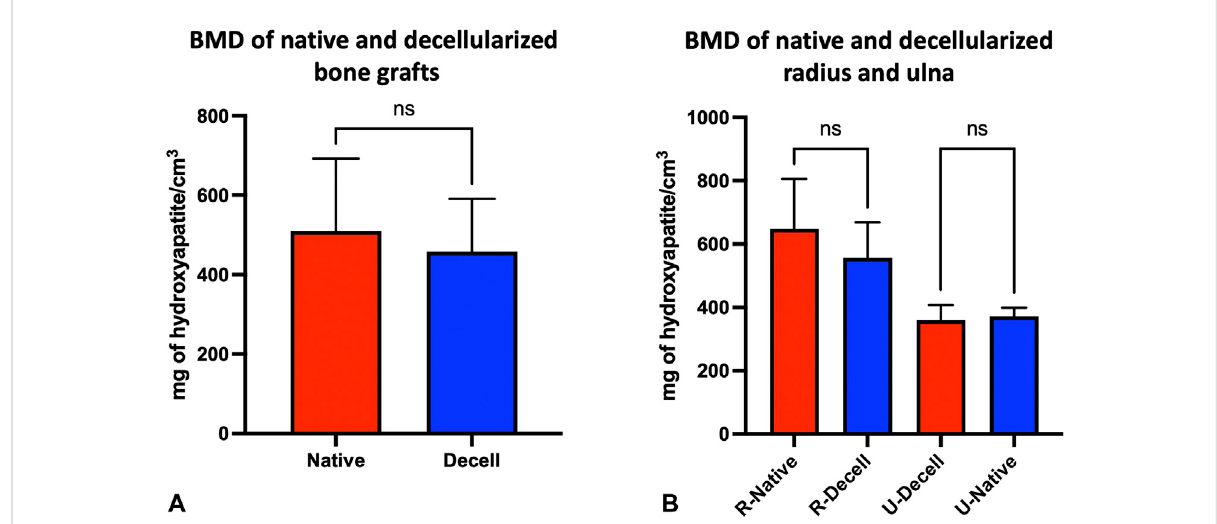
FIGURE 5 pQCT of vascularized bone grafts. (A – B) : Mean value of bone mineral density (BMD) before (native, red) and after decellularization (blue) of vascularizedbonegrafts(meanofeachulnarandradialBMDvalues) (A) .Speci fi cmeanvaluesofradial(R-)andulnar(U-)BMDbefore(native,red)and after decellularization (blue) (mean of the three mean values of radius or ulna BMD) (B) . BMD values were expressed in mg of hydroxyapatite/cm 3 ± SD (n = 3 different grafts; ns = not signi fi